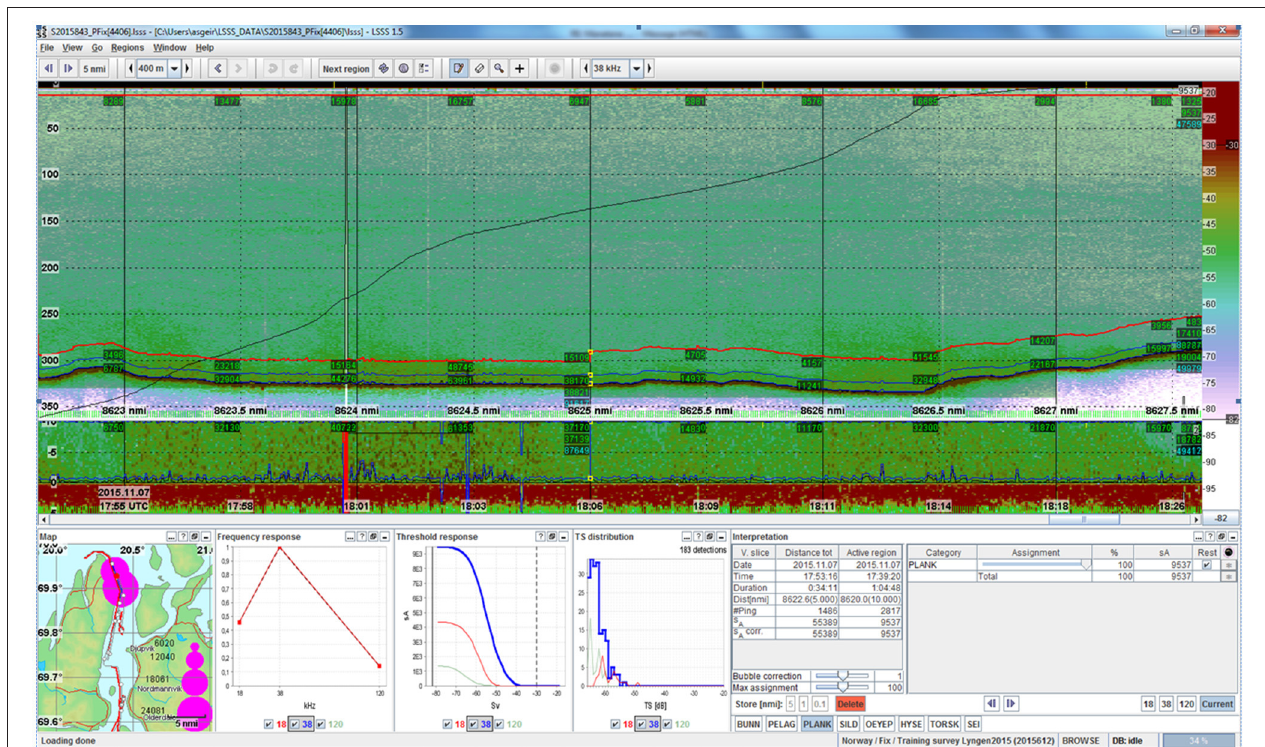
FIGURE 10 | Echogram from RV Helmer Hanssen recorded on 7 November 2015 just east of the northern tip of the Lyngen peninsula. Location of registrations is shown on the map in the lower left corner of the figure. The characteristic frequency response is shown next to the map. The threshold Sv,t = − 82 dB re 1 m − 1 . Time ∼ 17:55-18:18